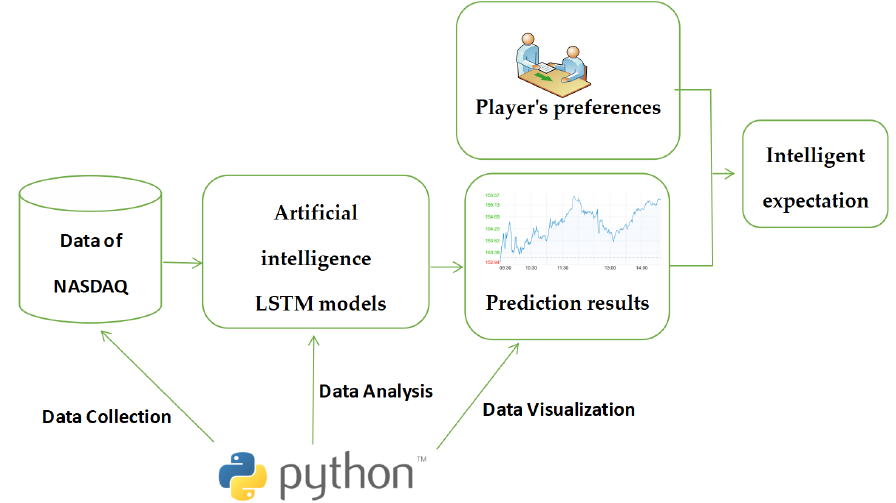
Figure 16. The Intelligent Expectation s by Python.